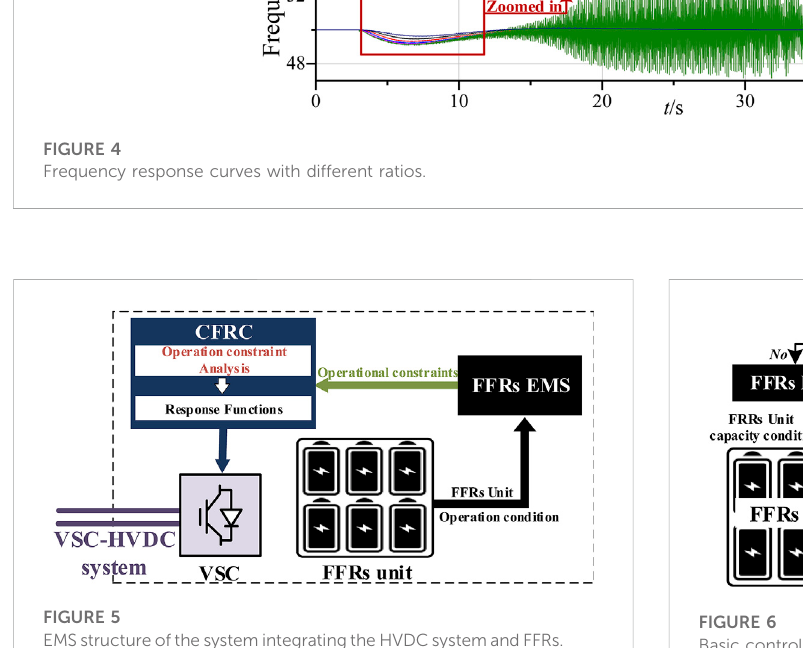
EMSstructureofthesystemintegratingtheHVDCsystemandFFRs.